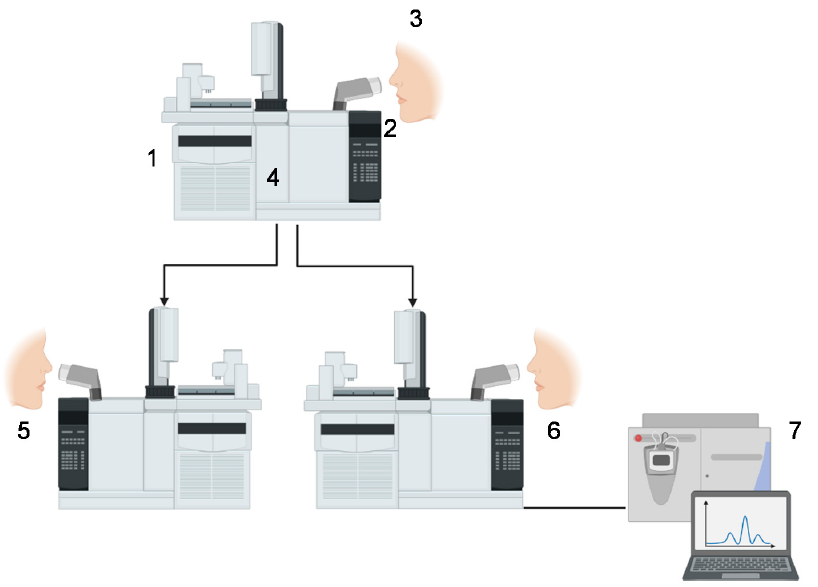
Figure 2. Scheme of analysis of chemical compounds to determine the aroma of fruits. 1—Injector; 2—stopwatch; 3—ODO; 4—oven; 5—ODO I; 6—ODO II; 7—mass 2—stopwatch; 3—ODO; 4—oven; 5—ODO I; 6—ODO II; 7—mass spectrum.